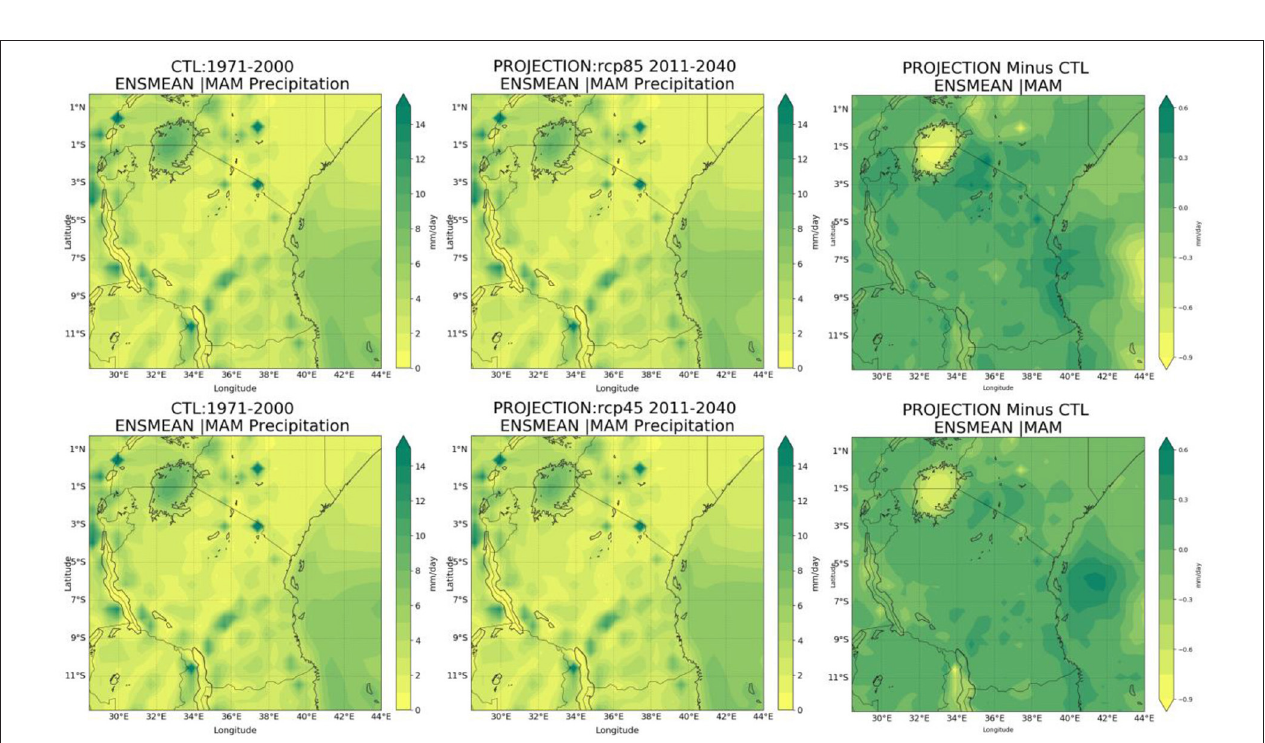
FIGURE 15 | Precipitation in mm/day for MAM during base period (1971–2000), present century (2011–2040), and change in precipitation under both RCP8.5 (upper) and RCP 4.5 (lower) .